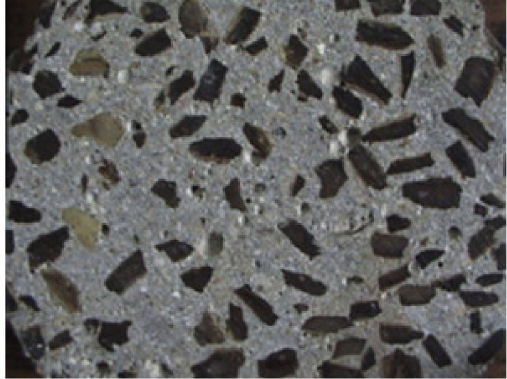
Figure 6. Cross-section of concrete made of coconut shells as coarse aggregate [53], with copyright permission from Elsevier.